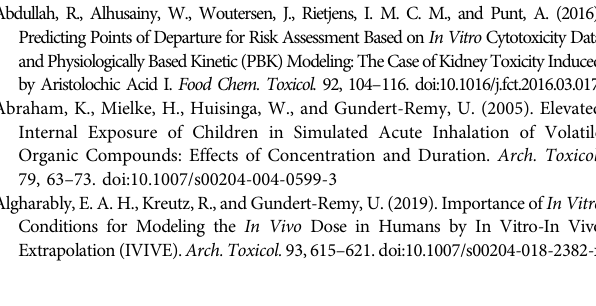
Supplementary Figure S1 | BMD modeling for the dose-response curve of the amiodarone effect on ChAT activity in human brain cells (model averaging). BMD, benchmark dose; ChAT, choline acetyl transferase. Supplementary Figure S2 | Simulated (line) and observed (point) plasma concentration – time pro fi les of IBU, following oral administration of a single 600 mg dose in an elderly male volunteer using two modeling platforms. (A) MATLAB. Conditions: fu of 0.01; hepatic clearance of 0.06 L/h/kg bw (Greenblatt et al., 2008) and tissue/plasma partition coef fi cient of 3.01; (B) PK- Sim ® . Conditions: fu of 0.01; hepatic clearance of 0.9 mL/min/kg (Greenblatt et al., 2008); speci fi c intestinal permeability (Peff) of 6.3e-06 cm/s (optimized in silico); tissue/plasma partition coef fi cient model according to Schmitt (2008), compared to experimental data reported by Greenblatt et al.